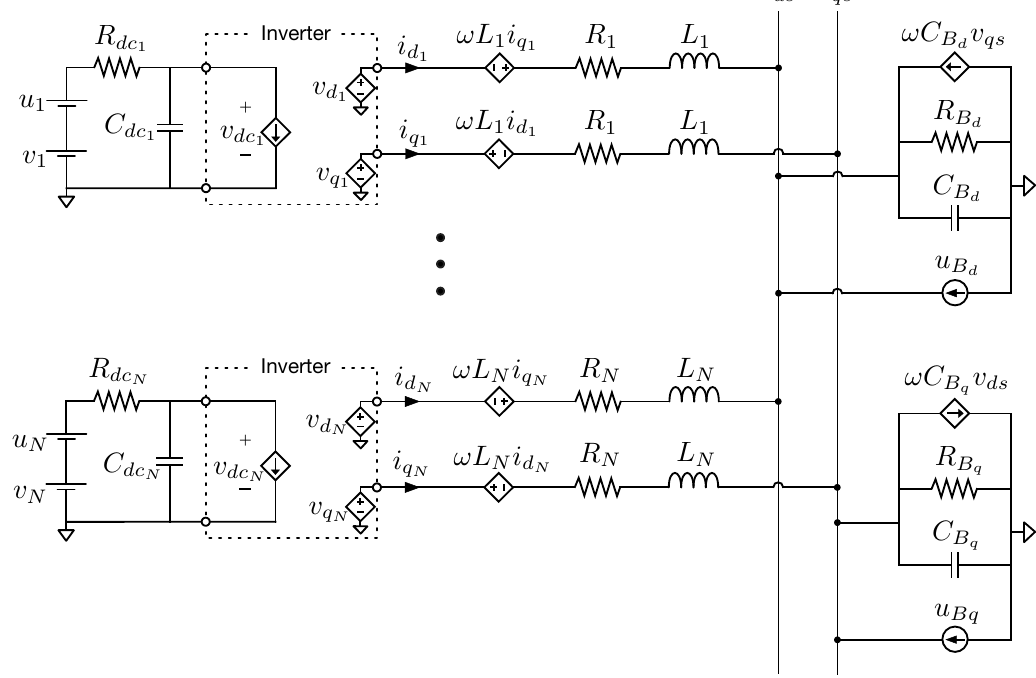
Figure 2. Schematic of an N -inverter system in the dq 0